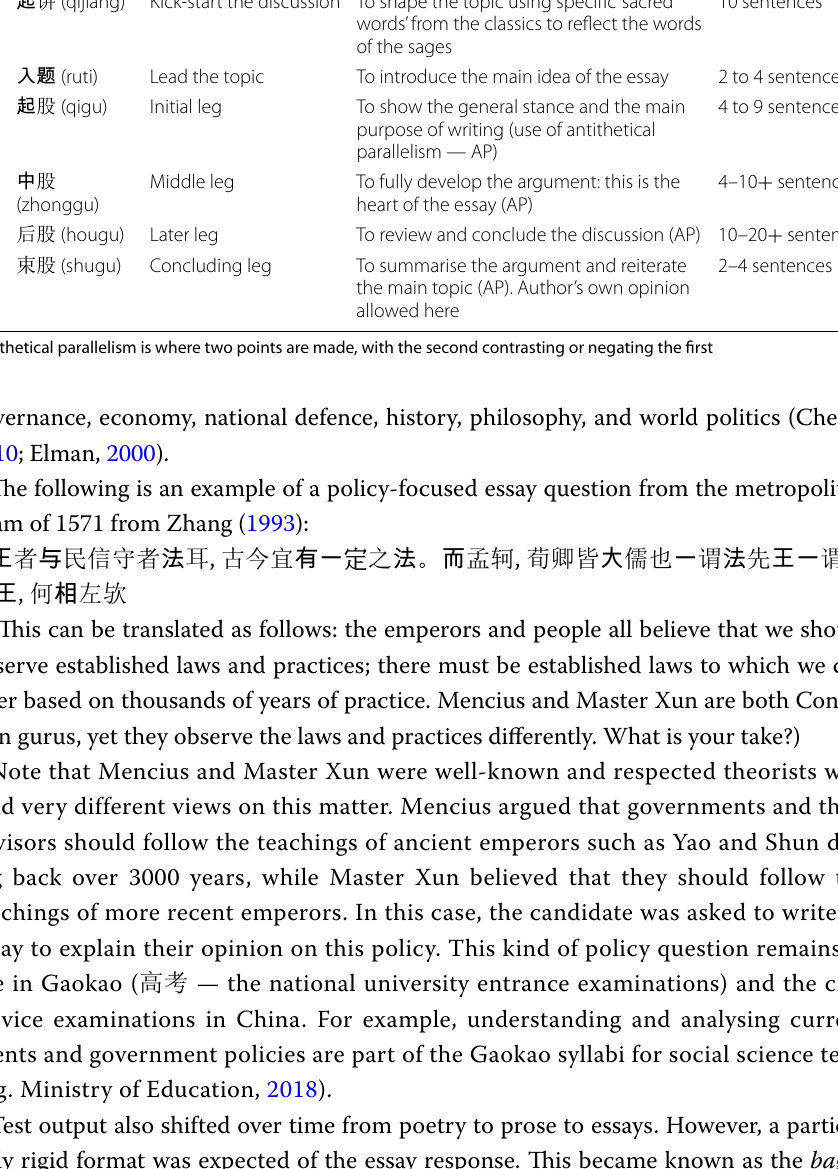
Table 3 Eight-legged essay structure